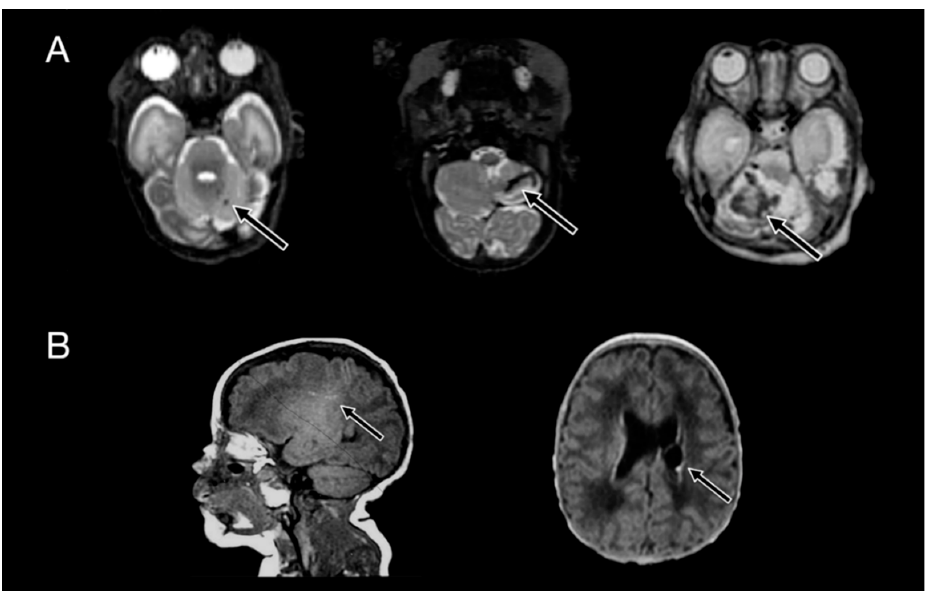
Figure 2. Cerebellar hemorrhage examples are shown on T2 sequences in ( A ): punctate injury is shown in the left column, small in the middle, and large in the right column. White matter injury examples are shown on T1 sequences in ( B ): punctate injury is shown at the left, while a cystic lesion is shown on the right. The primary focus of the injury is shown by the arrow.